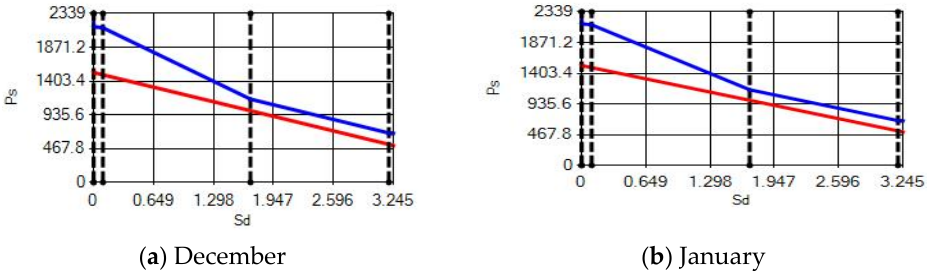
Figure 16. Condensation and evaporation amount chart in the building elements of the AAC external wall for the 3rd zone for ( a ) December and ( b ) January.